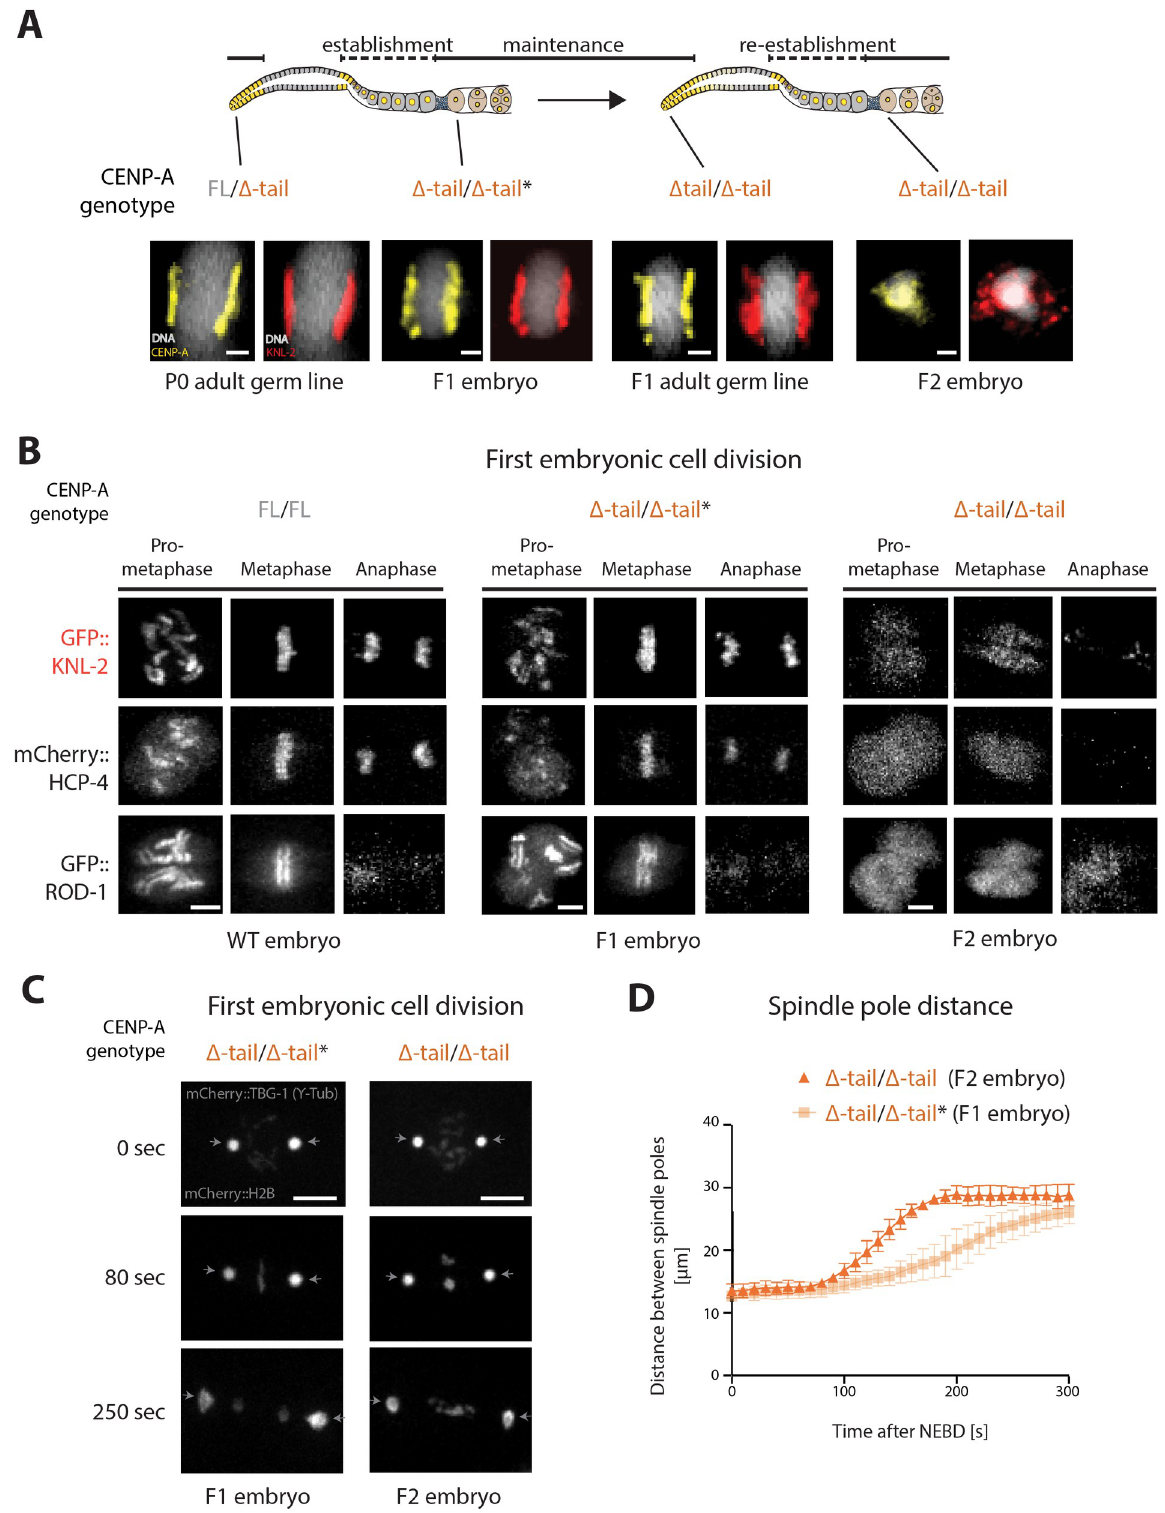
Fig 5. Centromere identity and function are maintained for one generation upon deletion of the CENP-A N-terminal tail. (A) Centromere biorientation in metaphase cells. IF images of KNL-2 and CENP-A Δ -tail in metaphase cells in the mitotic zone of the adult hermaphrodite germ line or in early embryos for the different generations (P0, F1, F2) of the CENP-A Δ -tail strain. (B) Still images for the indicated stages of mitosis